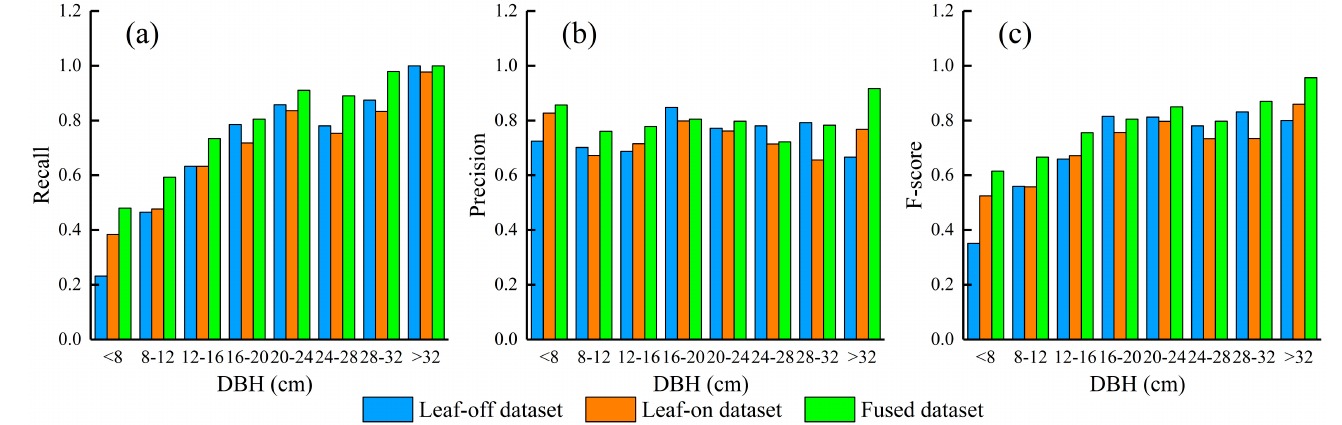
Figure 4. The performance of layer stacking segmentation algorithm on the leaf-off LiDAR dataset, leaf-on LiDAR dataset and the fused LiDAR dataset along a DBH gradient. ( a ) Recall; ( b ) Precision; ( c ) F -score.